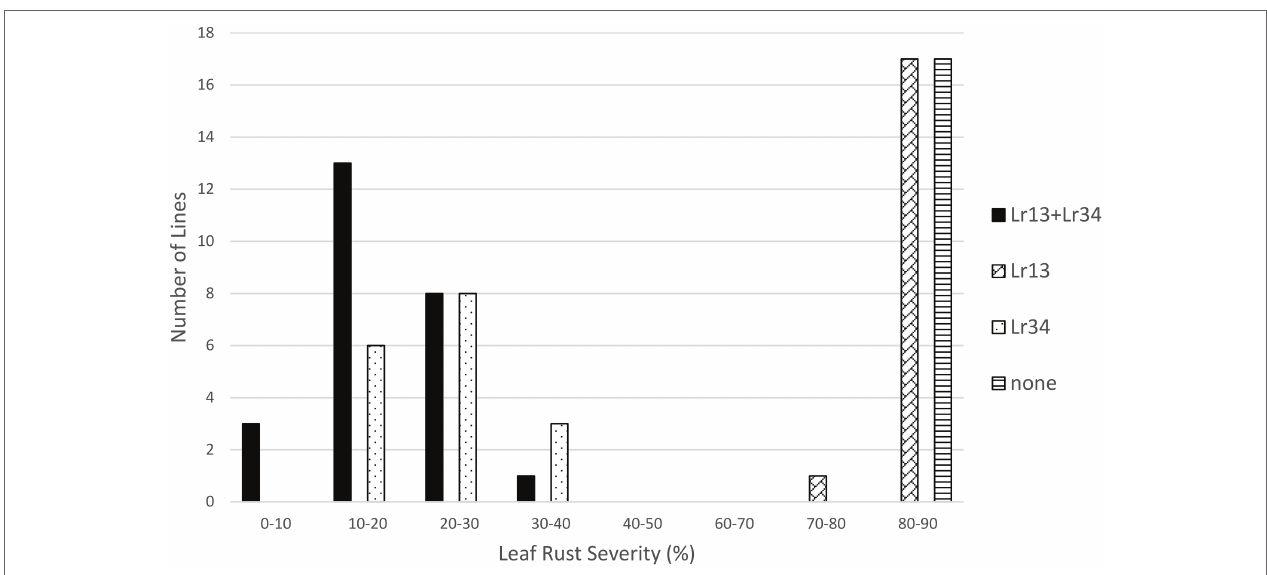
FIGURE 1 | Average leaf rust field severity (2012–2017) for progeny lines from the cross Lr13 / Lr34.